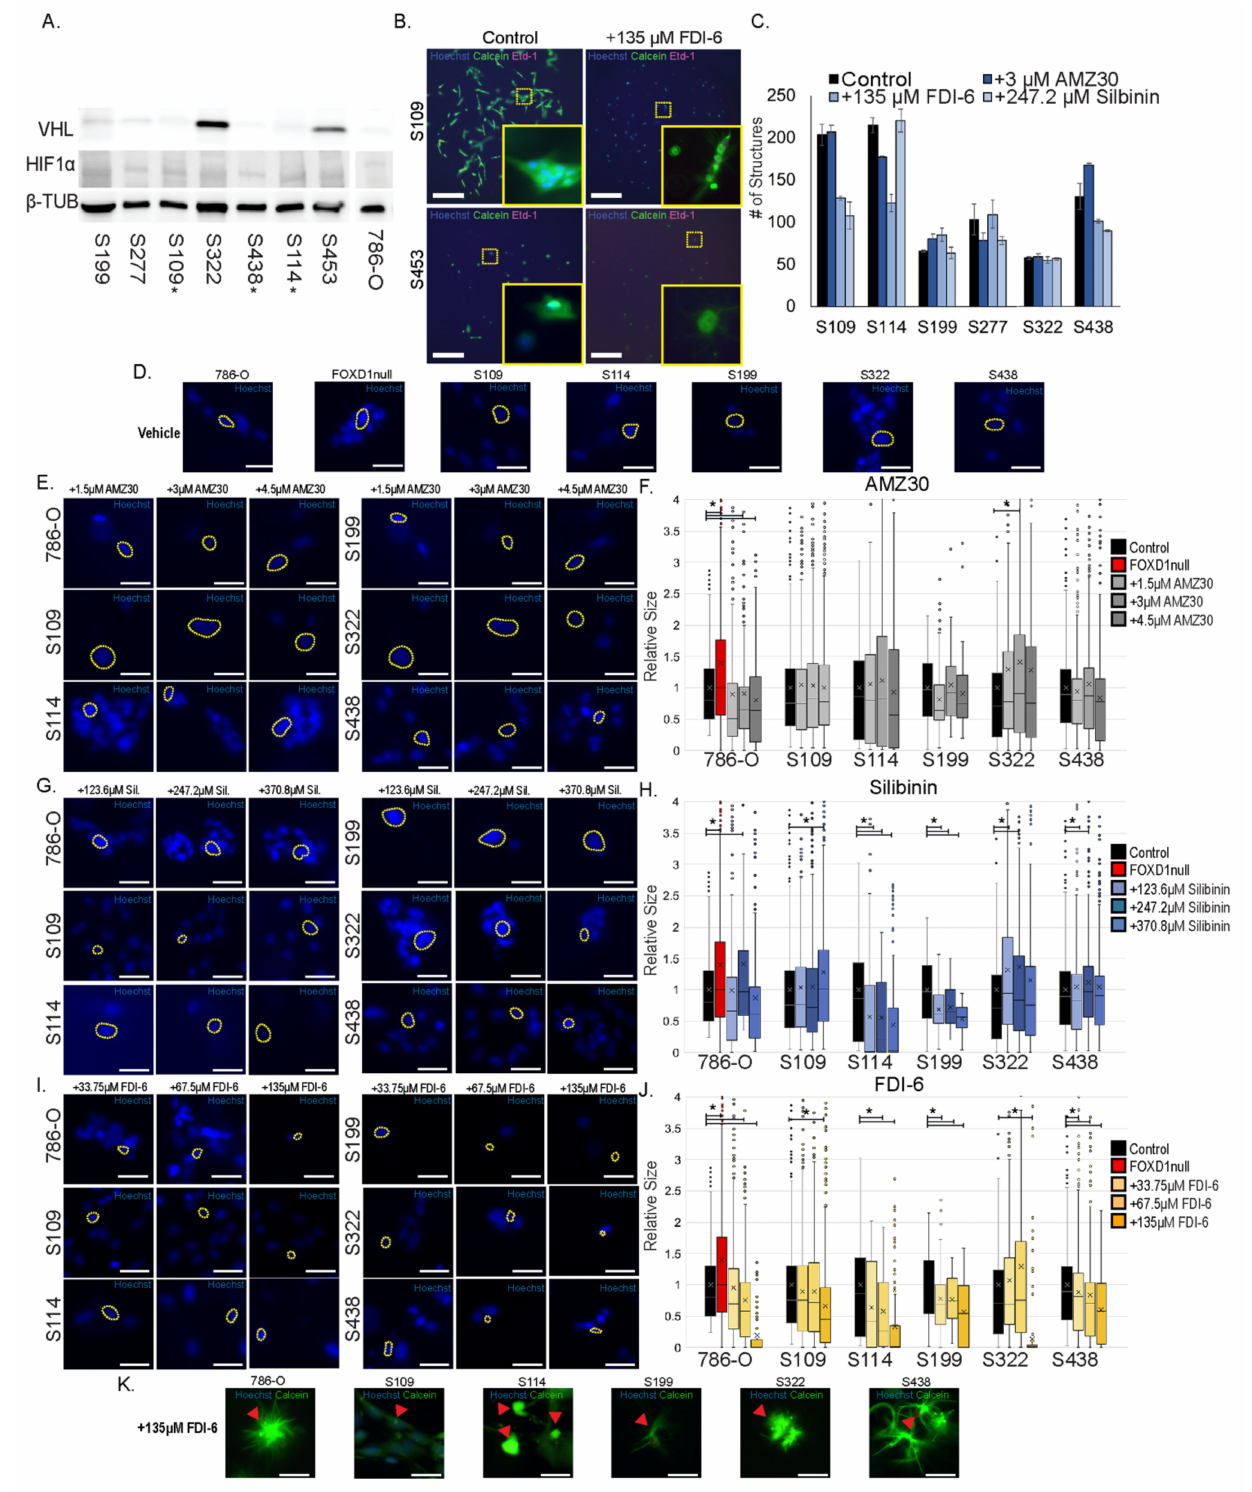
Figure 8. Test of candidate compounds on primary patient tumor replicas. ( A ) pseudo-hypoxia analysis of isolated primary cell lines and 786-O cells through Western Blotting (Figure S4 uncropped Western Blot Figures). * indicates potential true VHL null. ( B ) representative images of 3D cultures after three days treatment with FDI-6. All images can be found in Figure S1.